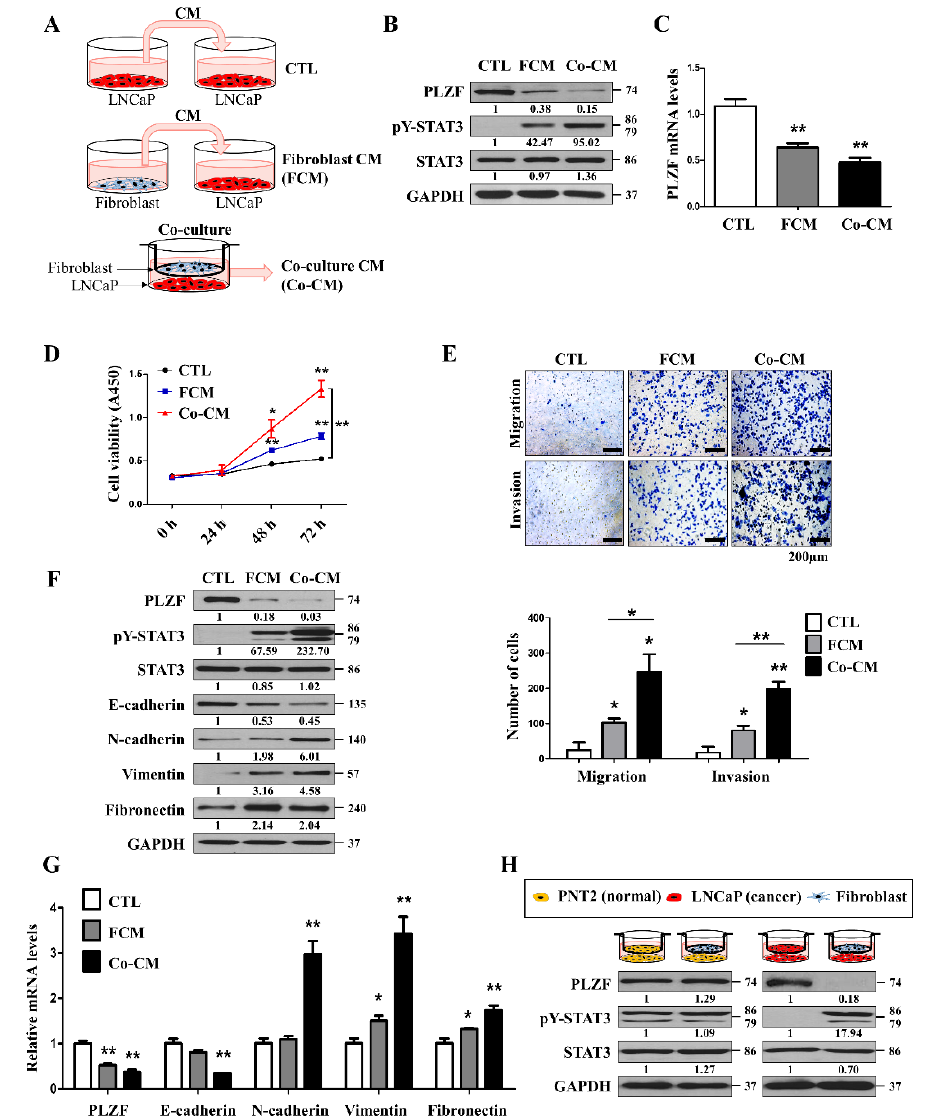
Figure 5. PLZF is reduced in prostate cancer due to the prostate tumor-associated fibroblasts. ( A ) Schematic of the experimental set-up for conditioned media (CMs) treatment and the Transwell co-culture system. Conditioned media (CM) were collected from fibroblast (FCM) that had been incubated for 48 h. LNCaP cells were cultured in a mixture of conditioned media and fresh media for 24 h ( = FCM). LNCaP cells were co-cultured with fibroblast using a cell culture chamber for 24 h and the cells in the lower chamber were lysed. ( B ) LNCaP cells with FCM or co-cultured with fibroblast for 24 h. LNCaP cells were lysed for Western blotting. ( C ) mRNA expression levels of PLZF were examined by qRT-PCR in LNCaP cells with FCM or co-culture. ( D ) Cell growth rates between FCM-treated cells and co-culture CM (Co-CM) were compared using a CCK assay. ( E ) Transwell migration and Matrigel invasion assays were conducted in LNCaP cells with FCM or Co-CM. The relative cell numbers are shown (bottom). Representative images from three independent experiments were quantified as the mean ± SD. ( F ) Protein expression levels of EMT markers in LNCaP cells with FCM or co-culture. ( G ) mRNA expression levels of epithelial–mesenchymal-transition (EMT) markers were examined by qRT-PCR in LNCaP cells with FCM or co-culture. ( H ) Prostate normal cells (PNT2) and prostate cancer cells (LNCaP) were co-cultured with fibroblast for 24 h. PLZF, pY-STAT3, STAT3, and GAPDH protein expression by Western blotting in LNCaP cells. * p < 0.05, ** p < 0.01. The uncropped blots and molecular weight markers of Figure 5 are shown in Figure S9 2.6. Loss of CCL3 Inhibits the Fibroblast-Induced Prostate Cancer Cells Migration and Invasion